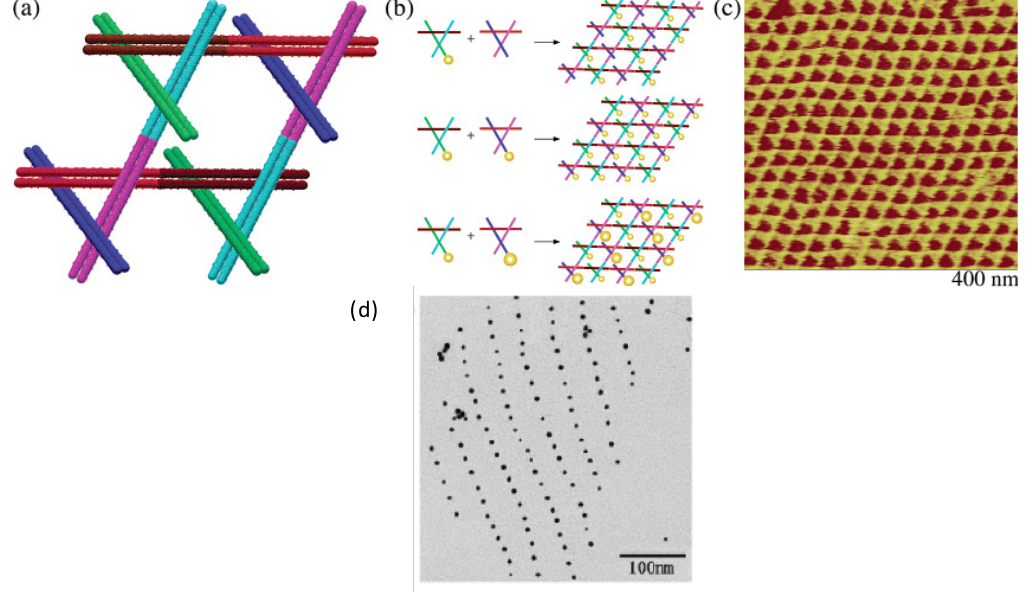
Figure 3. ( a ) DX DNA triangles can be made with sticky ends so that the triangles will tile together; ( b ) Not all the DNA ends are required for tiling and free ends can be attached to GNPs of 5 or 10 nm diameter (yellow); ( c ) AFM imaging of the DX array without addition of gold shows its regular structure; ( d ) When gold is attached, a regular array of GNPs can be formed on the DX DNA template, as shown by the TEM micrograph of a DX DNA array with alternating 5 nm and 10 nm GNPs attached. Only GNPs are visible in this image. ( a )–( d ) reprinted (adapted) with permission from Ref. [32]. Copyright 2006 American Chemical Society.